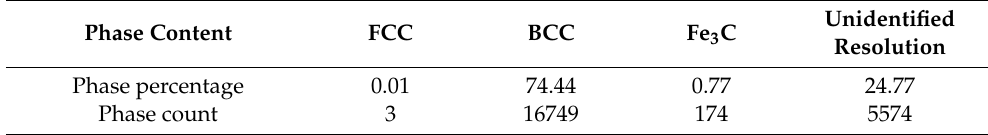
Figure 8. Results of EBSD in the OTZ of the LBW joint ( a ) Location of EBSD ( b ) Phase distribution. Table 2. Phase content in the OTZ of the LBW joint.